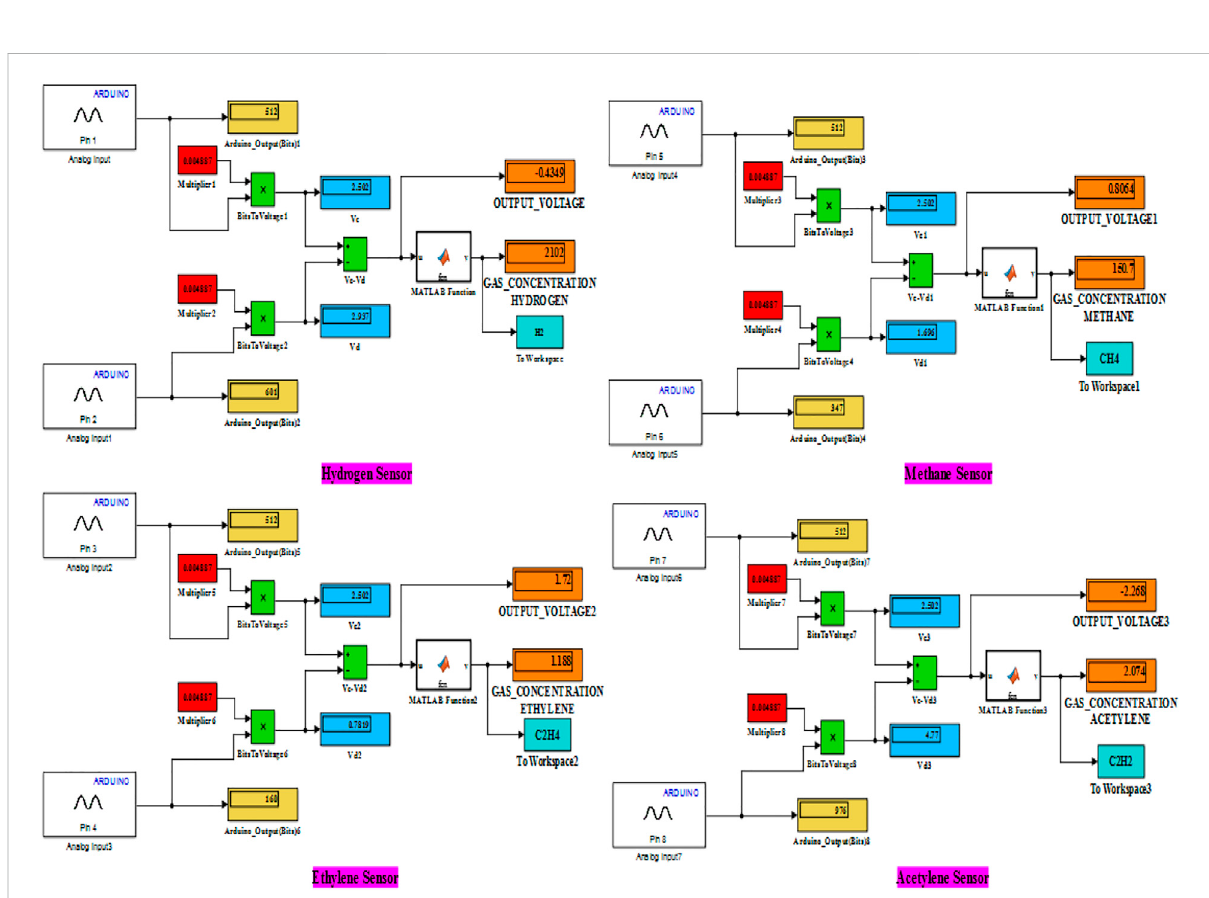
FIGURE 9 MATLAB subsystem for acquiring output voltages and conversion to gas